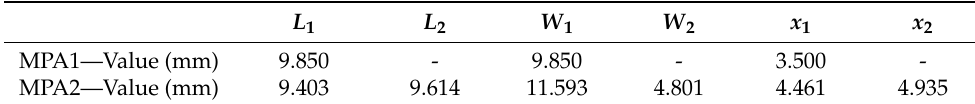
Figure 1. Microstrip patch antenna configurations: ( a ) MPA1, ( b ) MPA2.